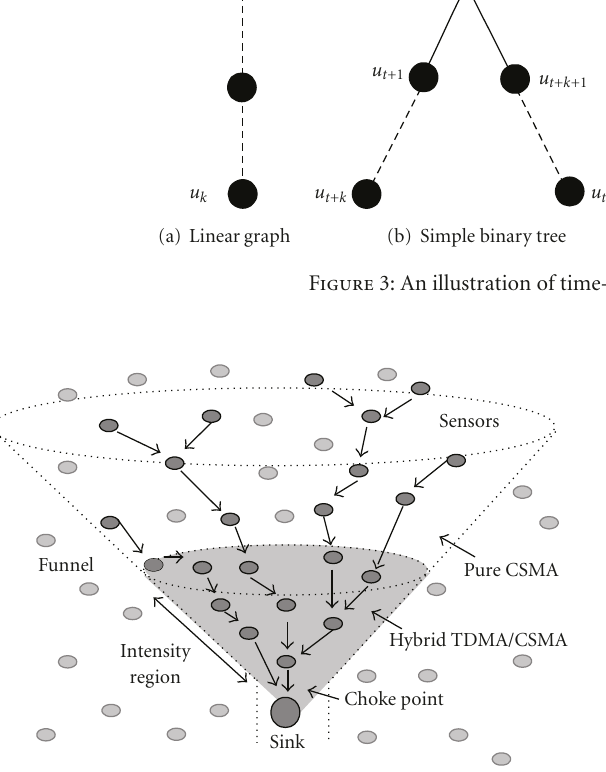
Figure 4: An illustration of funneling-MAC